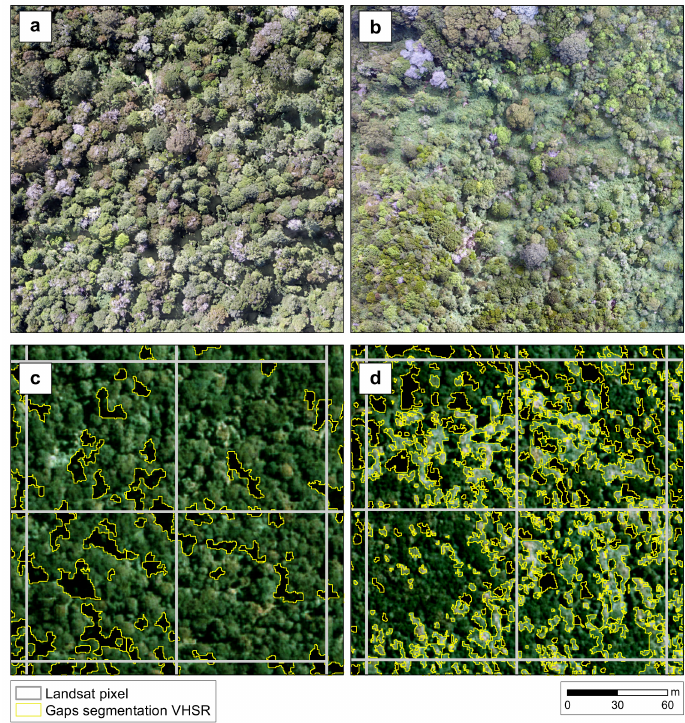
Figure 1. Example of intact forest canopies in Hueicolla ( a ) and San Pablo de Tregua ( c ) compared to altered forest canopies due to logging in Lomas del Sol ( b ) and Raulintal2 ( d ). Note how treefall gaps are small in size in ( a ) with a greater influence of shadows, whereas canopy gaps in the altered stand ( b ) are filled by Chusquea bamboos. Examples of the segmentation results are shown in ( c ) and ( d